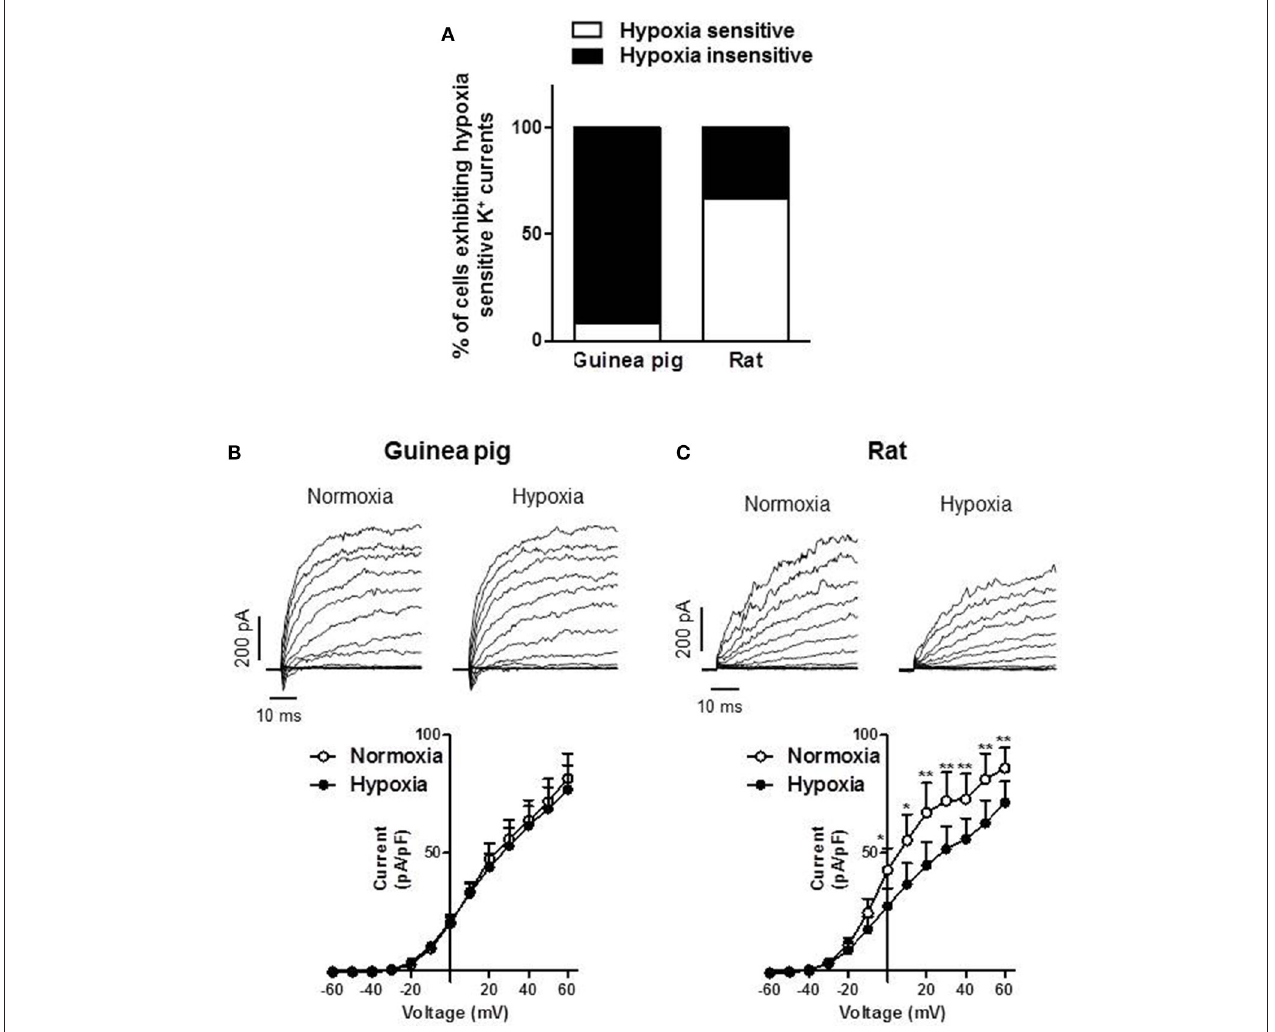
FIGURE 5 | Sensitivity of K + currents to hypoxia in guinea pig vs. rat type I cells. (A) Percentage of cells with hypoxic sensitive or insensitive K + currents isolated from guinea pig and rat CB. (B) Representative potassium current traces for 50 ms depolarization pulses from − 60 to + 60 mV in 10 mV increments from a holding potential of − 60 mV in isolated type I cells from 3 guinea pigs. (B) and 2 rats. (C) Superfused with normoxic (air-equilibrated) and hypoxic (N 2 -equilibrated) conditions. Current-voltage relationships of K + currents (I-V curves) are represented below. Data are expressed as mean ± SEM; *, ** p < 0.05 and 0.01 vs.